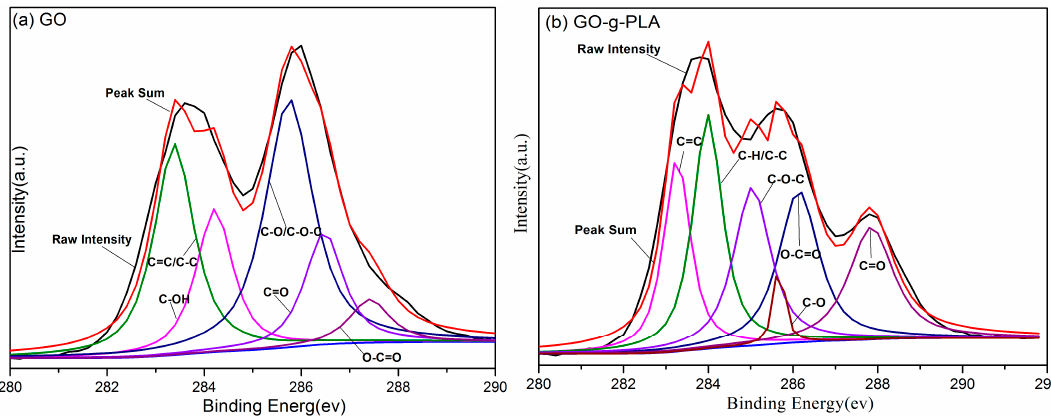
Figure 6. X-ray photoelectron spectroscopy (XPS) curves of ( a ) GO and ( b ) GO- g -PLLA.